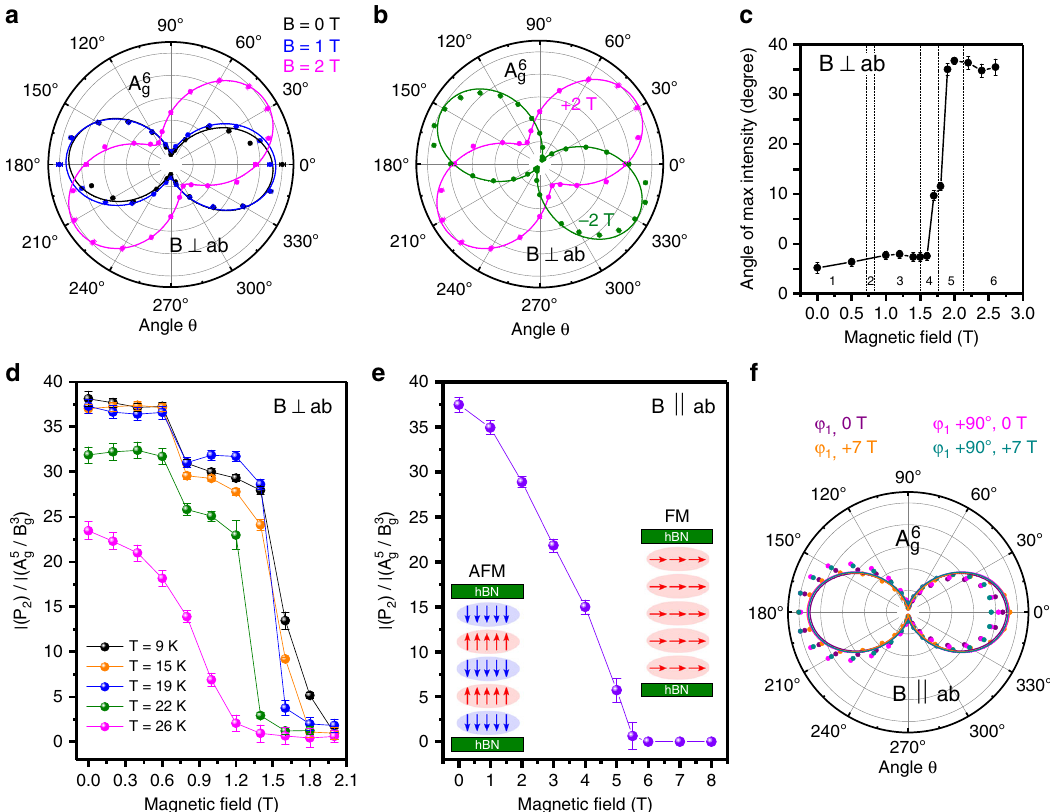
Fig. 4 Observable changes in the intensities and angular dependence of the Raman modes with applied magnetic fi eld. a Changes in the polar intensity (maximum intensity normalized to one), as a function of θ for (a) B = 0 T (black), 1 T (blue), and 2 T (magenta) for B ⊥ ab plane. b Comparing the of A 6 g at positive (magenta) and negative (green) applied magnetic fi elds. c Angle of maximum intensity in polar plot in a as a function of polar intensity of A 6 g magnetic fi eld, where fi eld ranges from Fig. 3b are marked. d Intensity of P 2 relative to the intensity of the combined mode A 5 as a function of applied magnetic fi eld ( B ⊥ ab plane) at various sample temperatures. e I P plane). Insets of e show the magnetic stacking orders in the AFM and FM states for B ∥ ab plane. f Polar intensity of A 6 parallel to the ab plane at two different crystal orientations ( φ 1 and φ 1 + 90°). Sample temperature was 9 K (2 K) for B ⊥ ab ( B ∥ ab). Error bars represent standard errors from fi tting